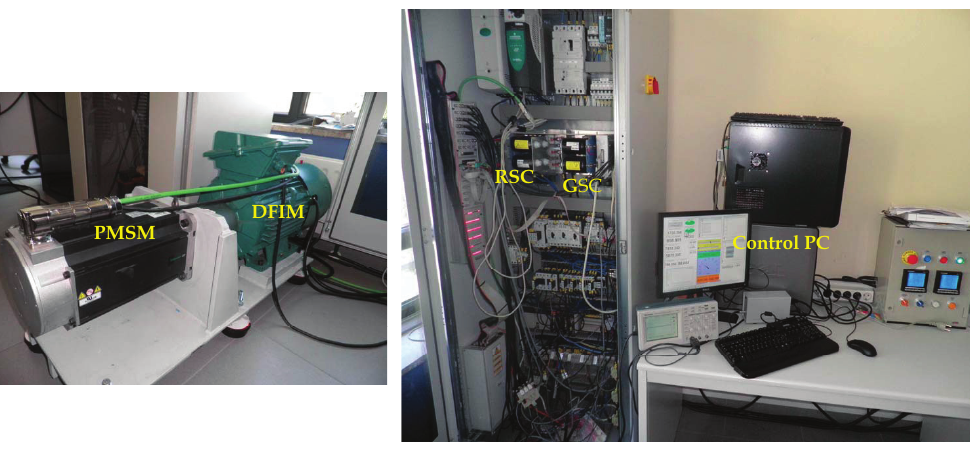
Figure 4. Photography of the DFIG wind turbine experimental